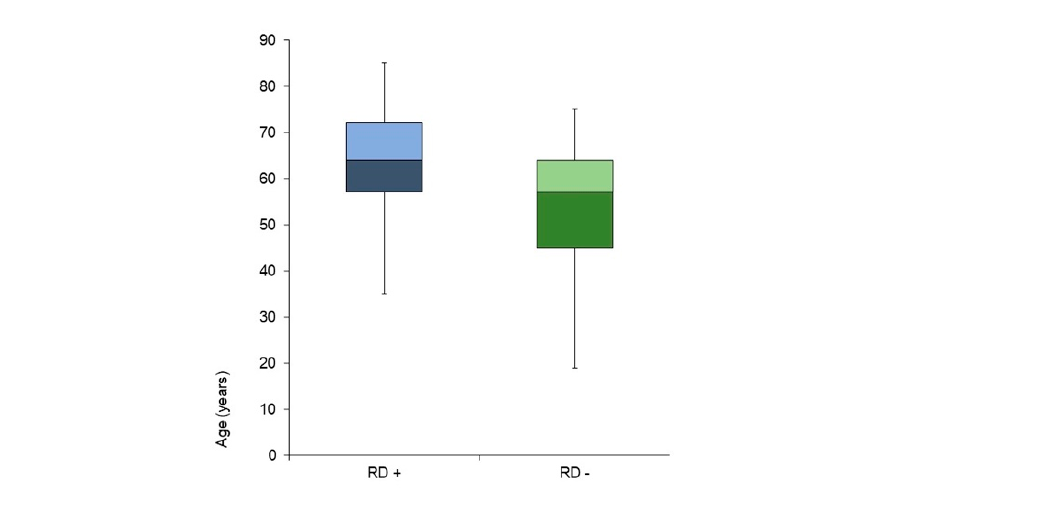
Figure 2. Residual dizziness reporting according to age. RD+, patients reporting residual dizziness; RD − , patients free from residual dizziness.